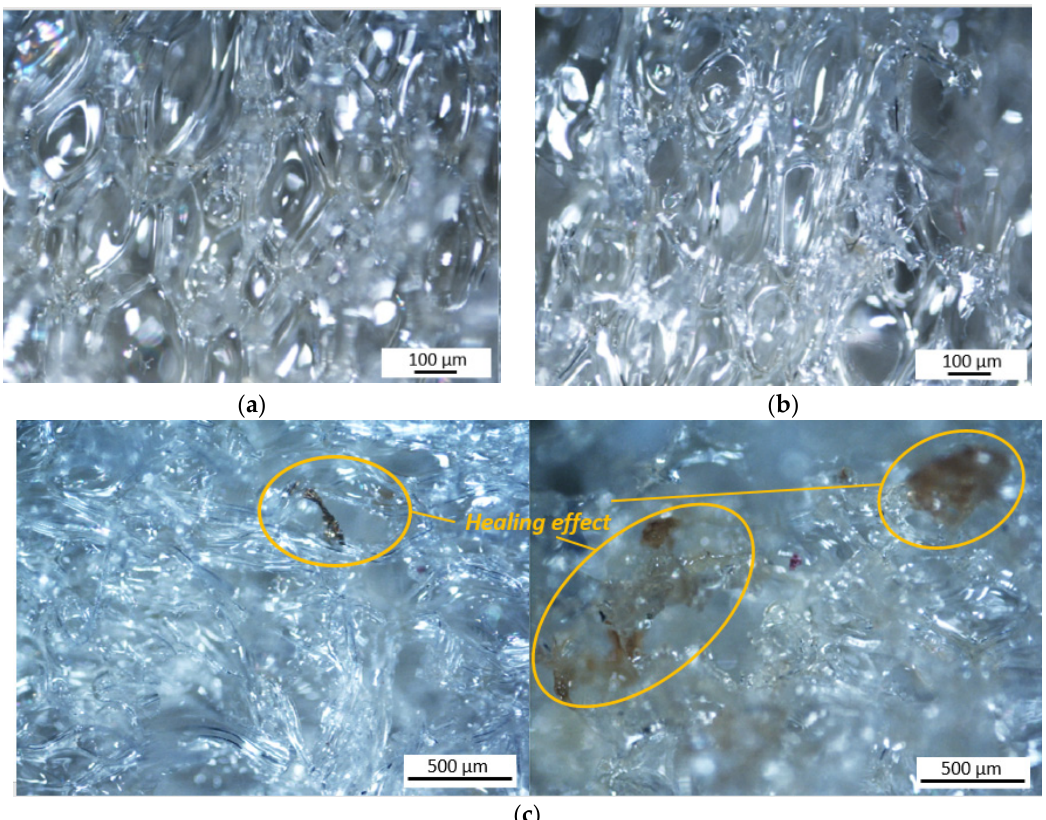
Figure 9. ( a , b ) optical microscopy images of PU foam after compression (shape fixity) before recovery; ( c ) images of PU foam after recovery (healing effect).